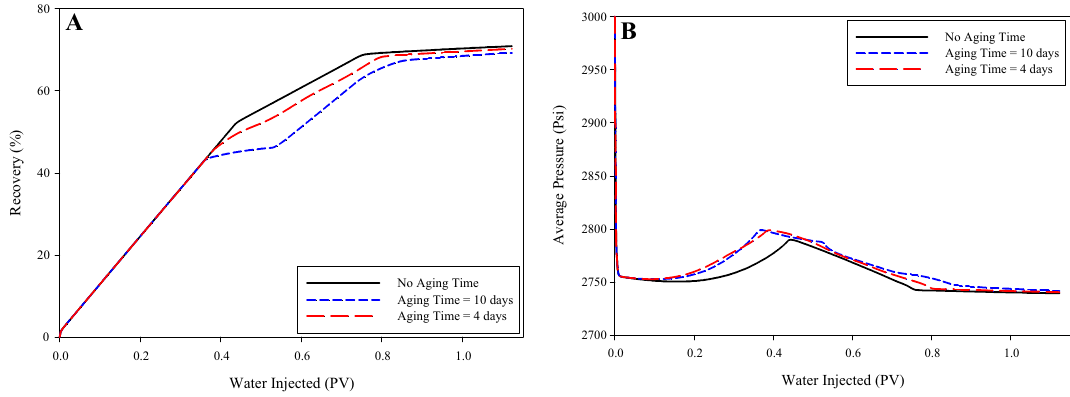
Fig. 14 a The oil recovery, and b well water cut of the model considering the aging time of 0, 4, and 10 days during LSW flooding versus PV of water